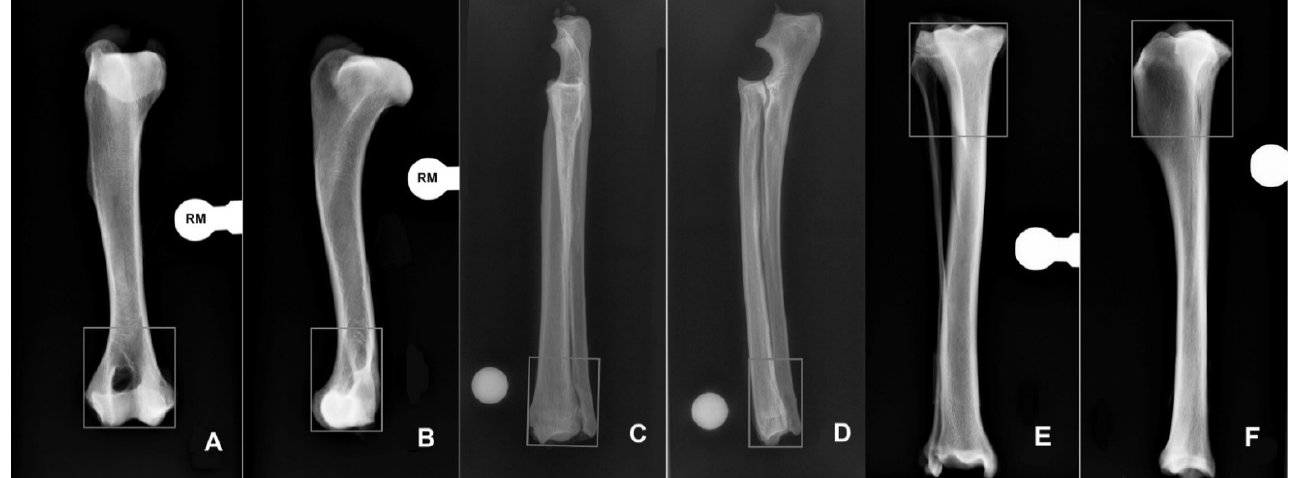
Figure 1. The fracture area (FA) of the humerus is represented by the distal quarter of the bone in both the CrCd ( A ) and ML ( B ) projections. The distal boundary is a line tangent to the joint, while the proximal one is a quarter of the way along the humeral length. The two connecting lines are parallel to the long axis of the humerus and tangent to the bone. The fracture area (FA) of the radius-ulna is represented by the distal quarter of the radial length in both the CrCd ( C ) and ML ( D ) projections. The distal boundary is a line tangent to the radial styloid, while the proximal one is a quarter of the way along the radial length. The two connecting lines are parallel to the long axis of the radius and tangent to the bone. The fracture area (FA) of the tibia is represented by the proximal quarter of the bone length in both the CrCd ( E ) and ML ( F ) projections. The proximal boundary is a line tangent to the joint, while the distal one is a quarter of the way along the tibial length down to the medial malleolus. The two connecting lines are parallel to the long axis of the tibia and tangent to the bone. In each bone segment, the FA represents the area where the fracture is supposed to be. Note that the radio-opaque marker (RM) is visible in each projection.